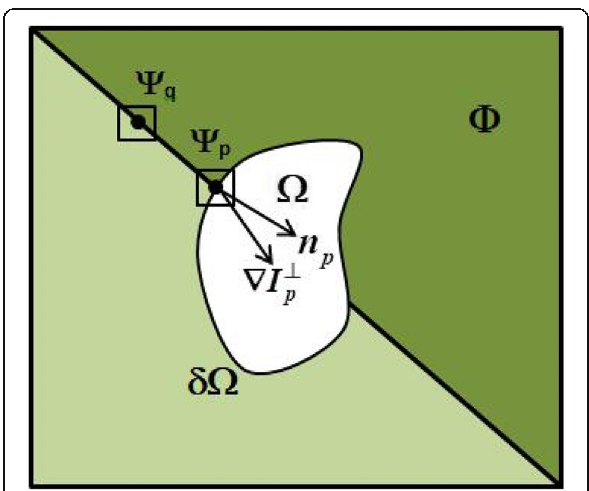
Fig. 2 Typical schematic diagram by exemplar-based inpainting. An original image I including the missing region Ω and the source region Φ . δ Ω is the boundary line of Ω and δ Ω ∈ Φ . Ψ p is a target patch centered at the pixel p ∈ Ω and is a source patch Ψ q centered at a pixel q ∈ Φ . n p is a unit vector orthogonal to δ Ω . ∇ I ⊥ isophote vector at point